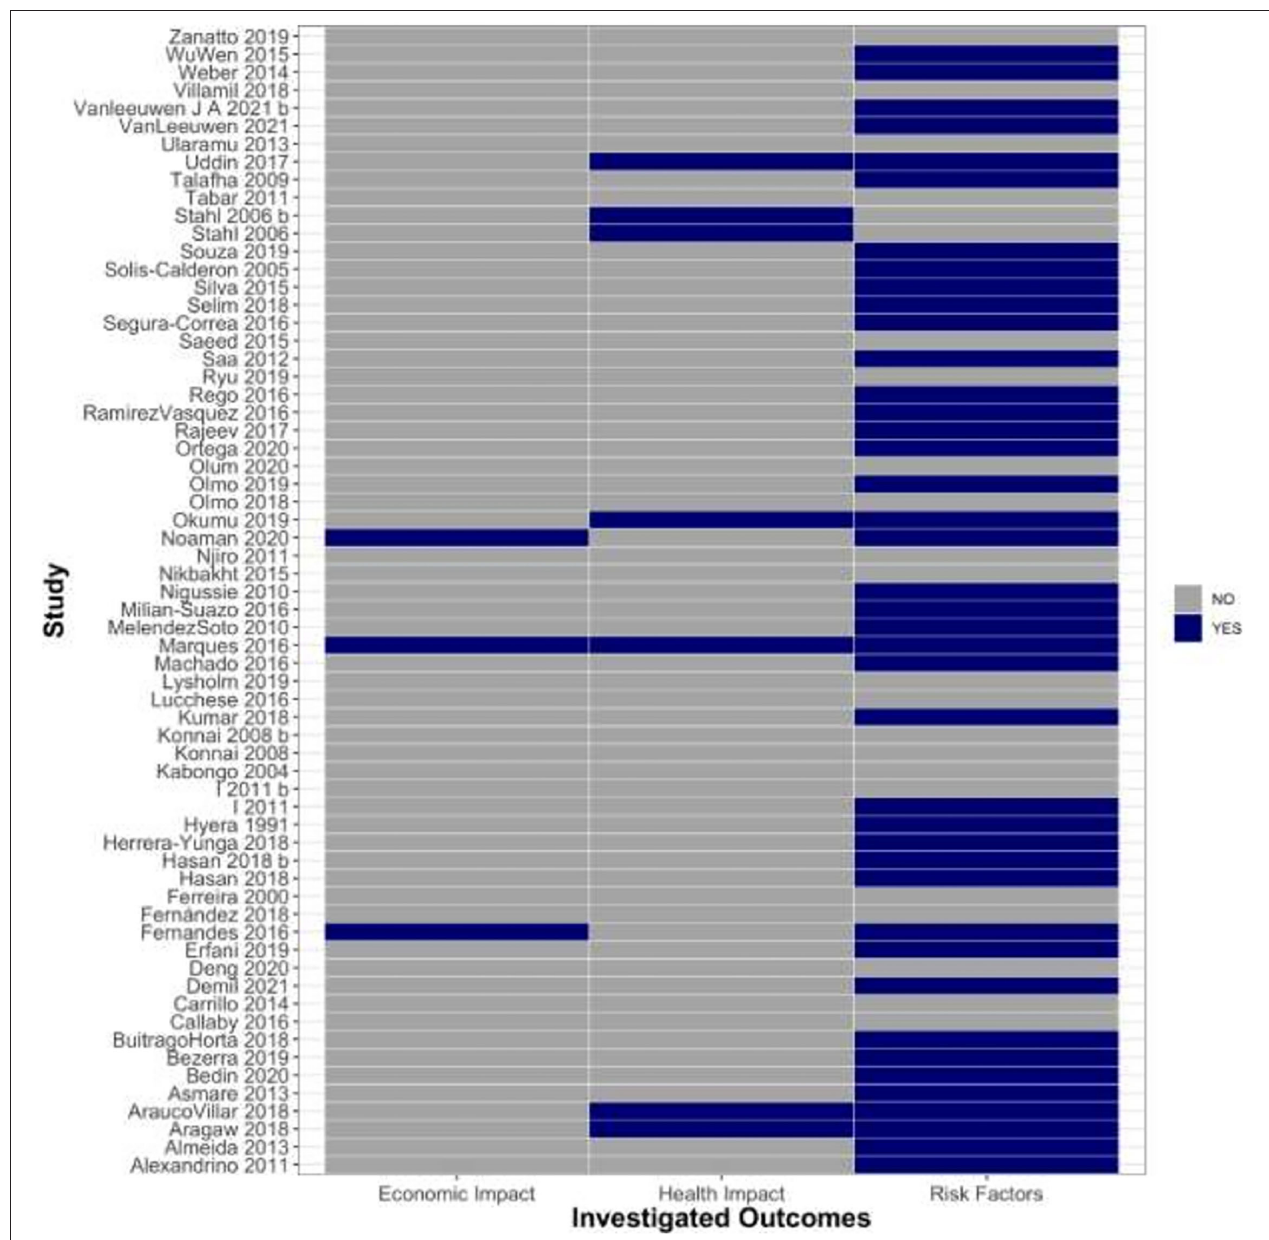
FIGURE 2 | Heatmap showing breakdown of study ID and the outcomes they analyzed. The plot shows the study authors’ contributions to investigation of the outcomes of interest for risk factors, health and economic impacts of BVD.